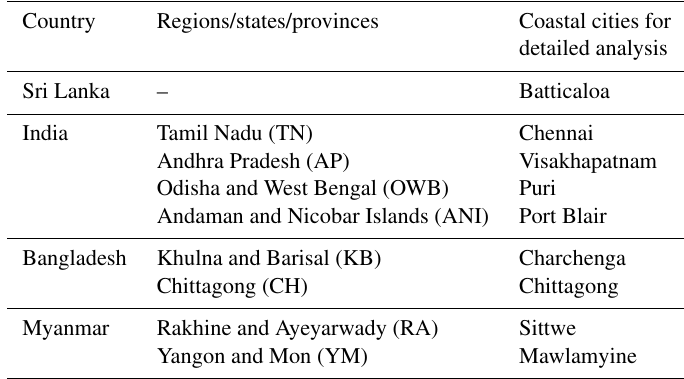
Table 1. List of countries, regions/states/provinces (abbreviation in parentheses) and coastal cities for further detailed analyses. Charchenga is sometimes also referred to as Charchanga (e.g., in Mamnun et al.,